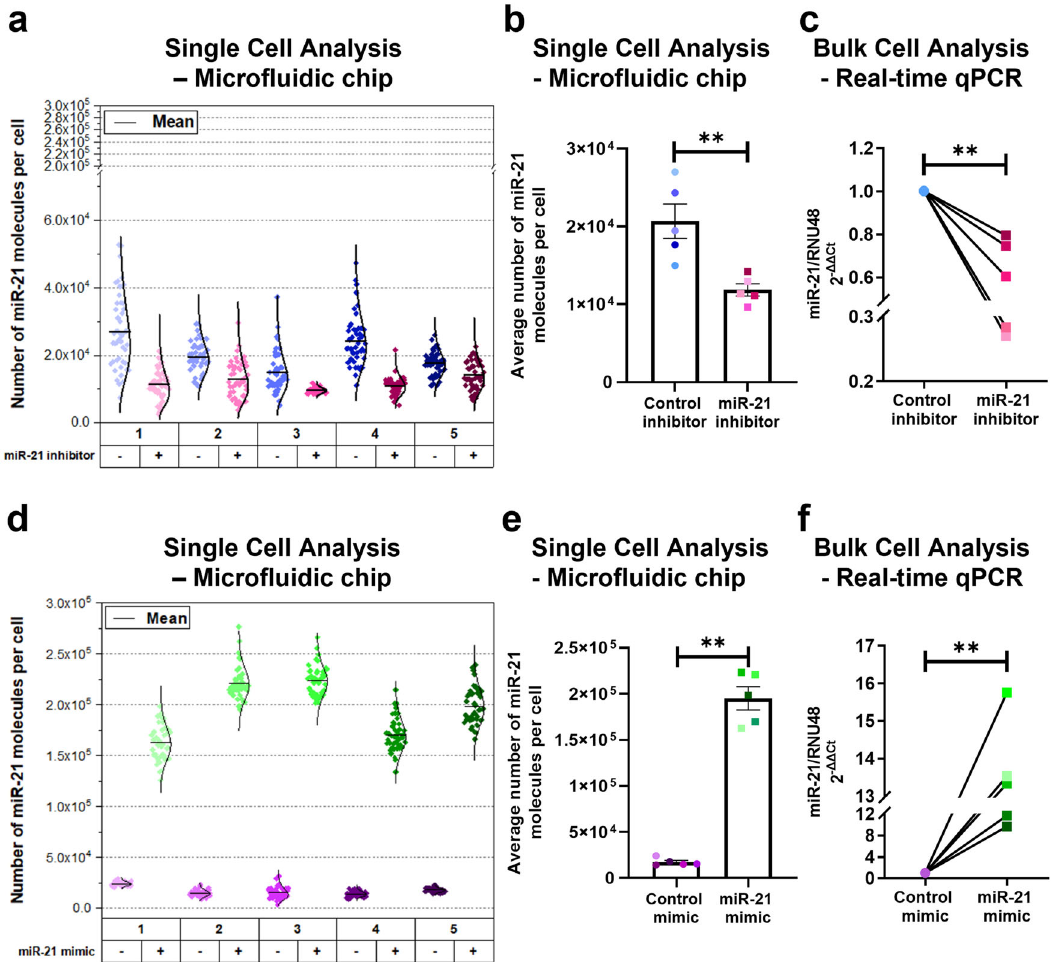
Fig. 4 Validation of miR-21 assay using speci fi c miR-21 mimics and antagomirs. BEAS-2B cells were overexpressed with miR-21 mimic (Green), miR-21 inhibitor (Pink), control mimic (Blue) or control inhibitor (Purple) for 24 h and the expression of miR-21 was assessed using micro fl uidic platform and real- time qPCR (n = 5). The same shade of colour represents the same population of BEAS-2B cells. The different shade of colour represents experimental repeats, labelled 1-5 ( a and d ). a Single-cell distribution of miR-21 molecules expressed in single BEAS-2B cells transfected with inhibitor or control. b Comparison of average miR-21 expression between BEAS-2B cells transfected with inhibitor and control measured by single-cell analysis. c Relative miR- 21 expression ( ΔΔ CT) in BEAS-2B cells transfected with inhibitor or control measured by real-time qPCR, normalised to RNU-48 and its control. d Distribution of miR-21 expression in BEAS-2B cells transfected with mimic or control measured in single cells. e Comparison of average miR-21 expression in single BEAS-2B cells transfected with mimic or control. f Relative miR-21 expression ( ΔΔ CT) in BEAS-2B cells transfected with mimic or control by real-time qPCR, normalised to RNU-48 and its control. The black solid line represents a normal or gamma distribution fi t to the data and the mean. Data were analysed using Mann – Whitney U -test, ** p <